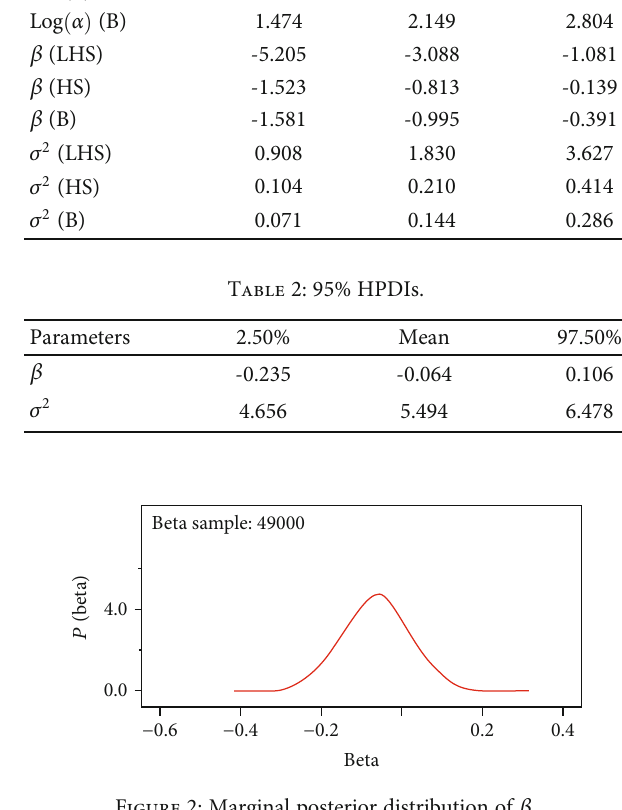
Figure 2: Marginal posterior distribution of β .